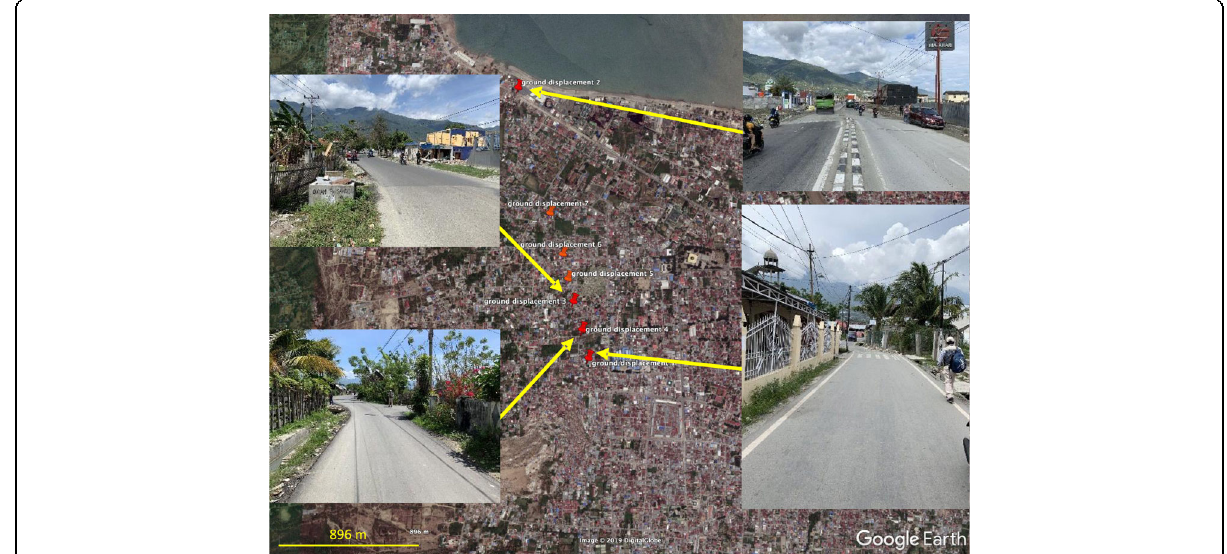
Fig. 2 Ground displacement induced by fault movement in Palu city